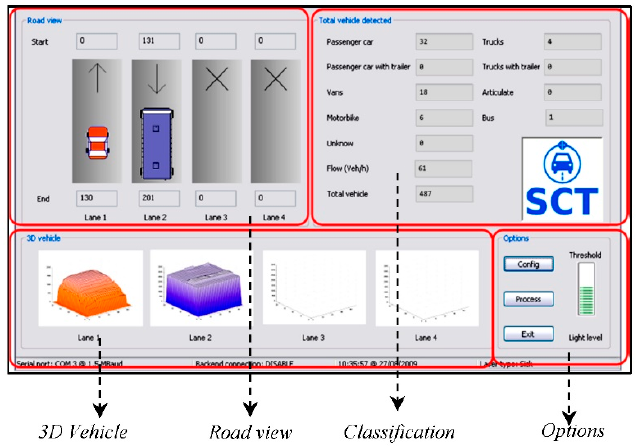
Figure 14. Operation of our system at the described location.